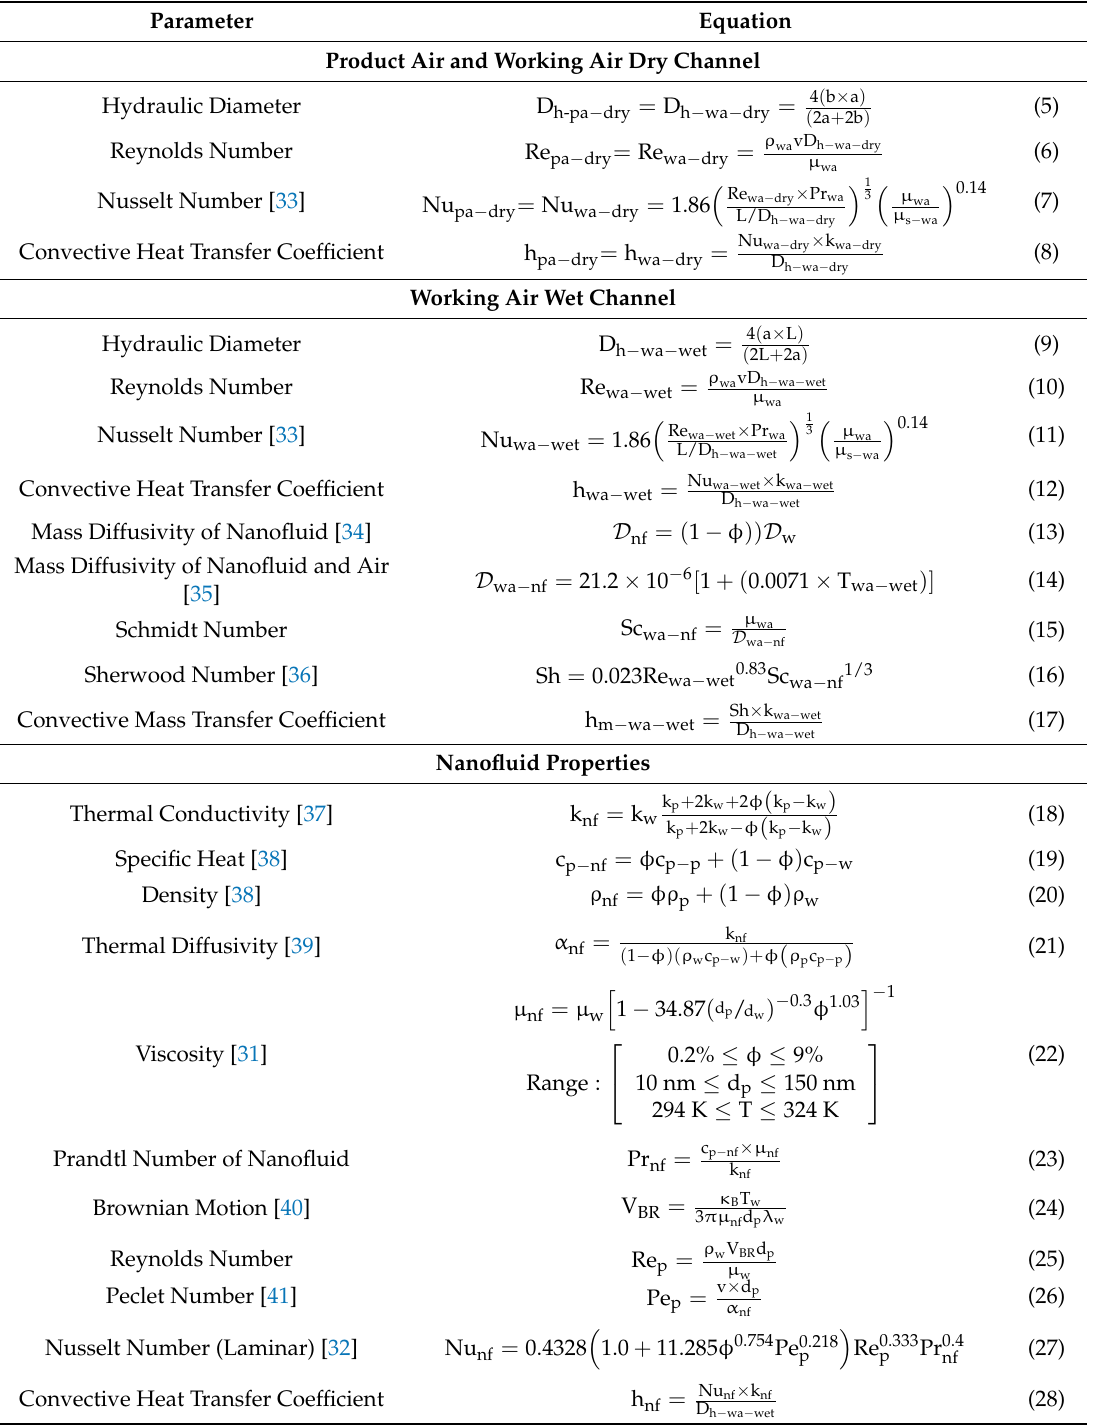
Table 2. Details of the calculation of the heat and mass transfer parameters of the fluids.